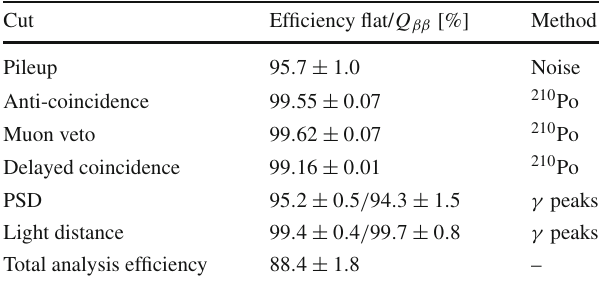
Table 2 Efficiencies for CUPID-Mo selection cuts, evaluated either as a constant efficiency or linearly extrapolated to Q ββ . Methods used to compute each efficiency are indicated (see